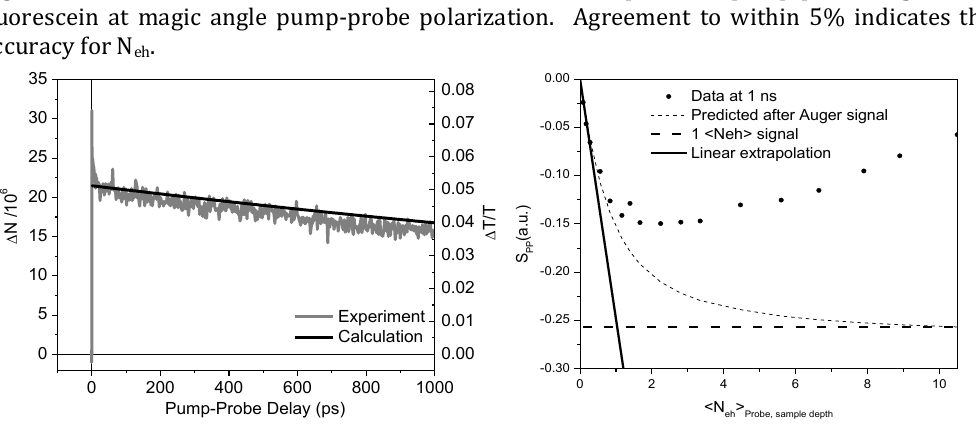
Fig.1. (left) Absolute change in the number of probe photons transmitted through fluorescein dianion in basic methanol for a magic angle pump-probe transient as a function of pump-probe delay. The experimental measurement (grey) is compared to a calculation without any adjustable parameters (black), verifying the absolute number of pump photons absorbed. Fig. 2 (right) Pump-probe signal for 8 nm PbS dots averaged from 700 ps to 1 ns (solid circle) as a function of <N eh >. The solid black line is the linear extrapolation from the data at low <N eh >. The short dashed curve assumes all excited dots, regardless of N eh , end up with N eh = 1 (complete AR). At high <N eh >, the short dashed curve approaches the linear extrapolation of the low <N eh > data to <N eh >=1 (long dashed horizontal line): Data (dots) show the assumptions of the standard Auger analysis fail below <N eh > =